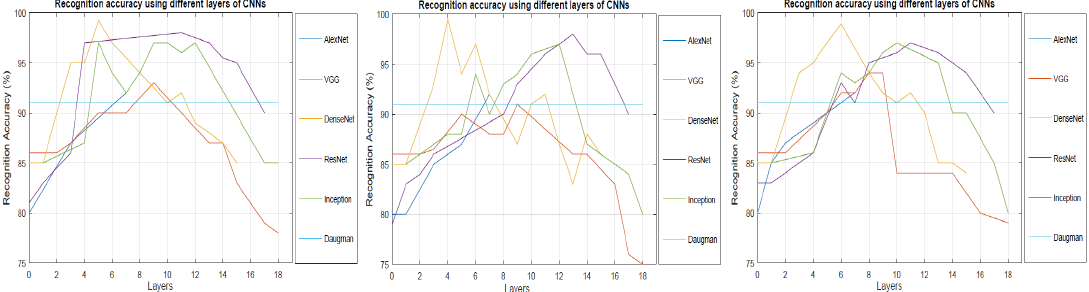
Figure 10. Quantitative analysis by comparison with Recognition accuracy different layers of CNNs for three databases from left to right respectively: CASIA-Iris-Thousand dataset,UBIRIS.v2 and